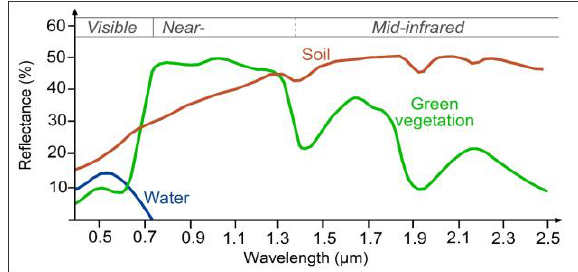
Figure 1. Reflectance of water, bare soil and vegetation in different wavelengths, source: SEOS